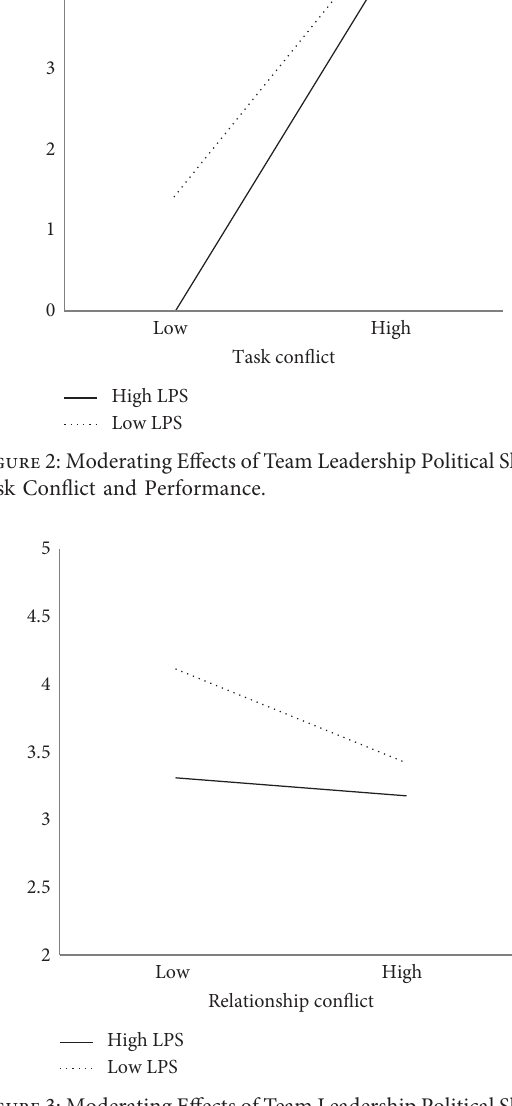
Figure 3: Moderating Effects of Team Leadership Political Skills on Relationship Conflict and